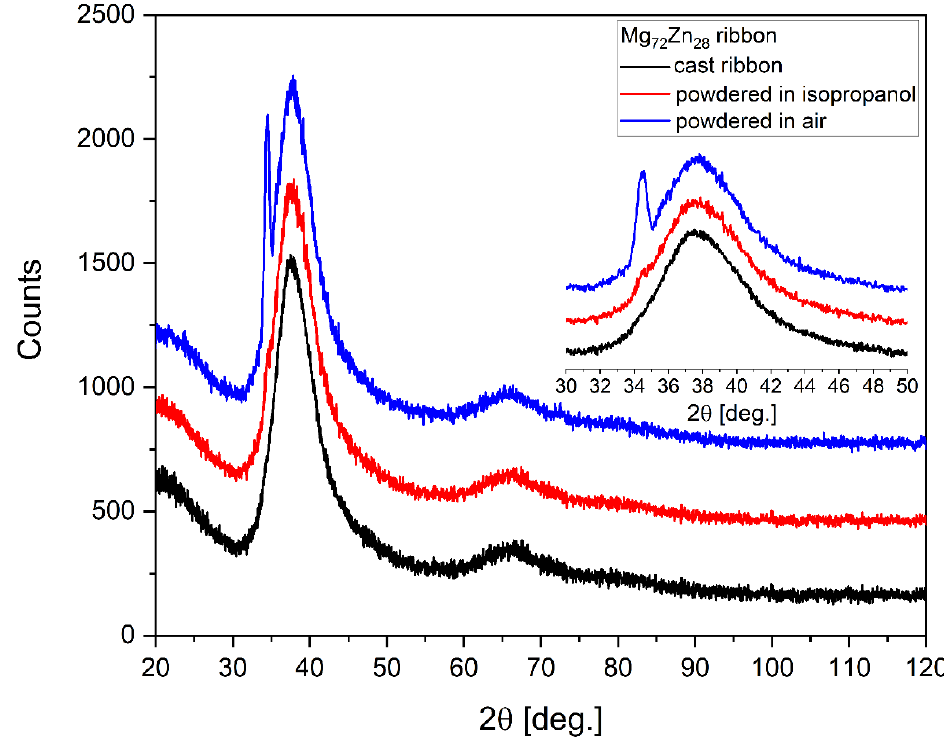
Figure 1. The X-ray (Cu Kα) diffraction patterns of Mg 72 Zn 28 powdered and cast ribbon. In order to select the temperature of isothermal annealing, the amorphous ribbon was heated to a temperature of about 725 K at a speed of 5 K/min (Figure 2). The curve shows two overlapping exothermic peaks, one smaller exothermic peak, and two separate endothermic peaks. The first two overlapping exothermic peaks are related to the crystallization of two phases. At 358.12 K, the α-Mg phase crystallizes first (smaller peak), and then, at a temperature of about 374.76 K, the Mg 12 Zn 13 phase crystallizes (bigger peak). Thus, in the temperature range between 358.12 K and 374.76 K, there are two structural components: amorphous and crystalline α-Mg phases. Two maxima can be distinguished for these two overlapping exothermic peaks, indicating the maximum heat release intensity. The first is at a temperature value of 371.0 K ( α -Mg), and the second is at 382.52 K (Mg 12 Zn 13 ). A small exothermic peak is visible in the temperature range from 475 K to 599 K and is associated with the Mg 2 Zn 11 crystallization procedure. The first endothermic peak relates to the eutectic transformation, and the second to the melting of α -Mg. This allowed us to identify the initial crystallization temperature ( T x = 358.12 K) and the eutectic temperature (T = 614 K). The total amount of heat obtained from exothermic peaks is ∆ H ∆ H ∆ H exo = 55 J/g, while from endothermic peaks is exo is about endo = 191 J/g. Thus three times smaller than ∆ H endo . The same phenomenon was observed by the authors of the publication [22]. This phenomenon is probably due to the large excess specific heat of the supercooled liquid relative to the solid and perhaps a small loss of enthalpy during heating to the crystallization temperature. The very low temperature of the beginning of crystallization of the two-component Mg-Zn alloy compared to the three-component Mg-Zn-Ca alloy (about 506 K) [15,16] suggests the low stability of the amorphous struc- ture of the two-component alloy at ambient temperature. This may lead to spontaneous crystallization of this alloy at ambient temperature. The value of the initial crystallization temperature allowed two values of the isothermal annealing temperature (352 K and 355 K) to be selected, which are lower than the initial crystallization